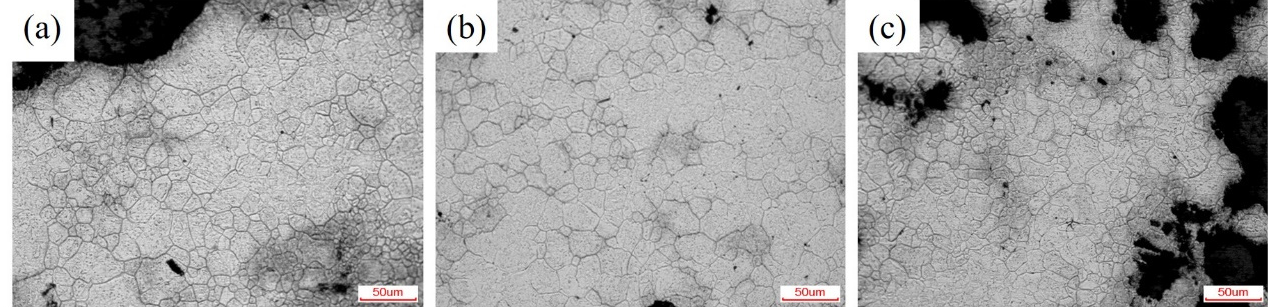
Figure 3. Microstructures of point P2 in ( a ) Sample 1; ( b ) Sample 2; ( c ) Sample 3.